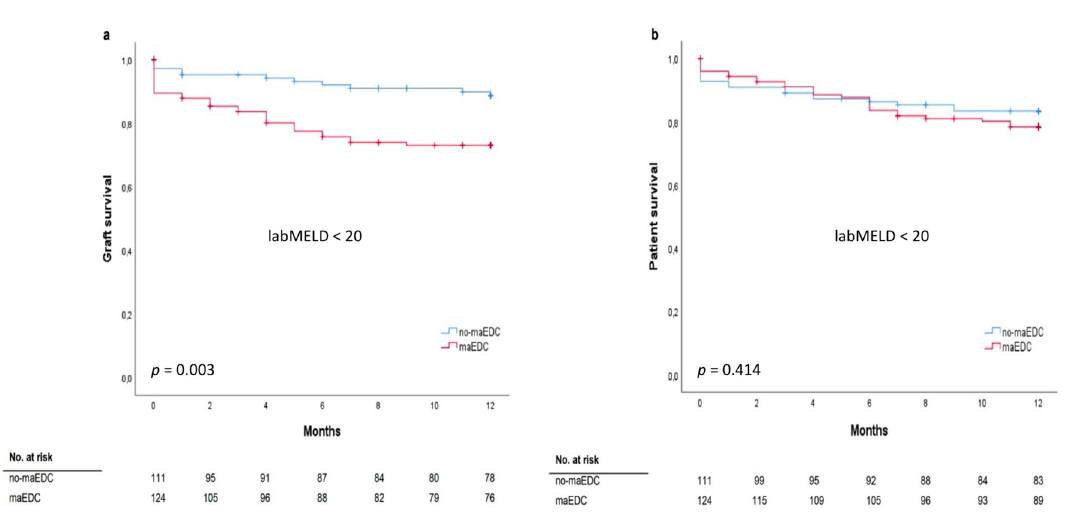
Figure 3. Graft survival ( a ) (log-rank p = 0.003) and patient survival analysis ( b ) (log-rank p = 0.414) of recipients with a labMELD score of <20 who were transplanted with no-maEDC and maEDC grafts.